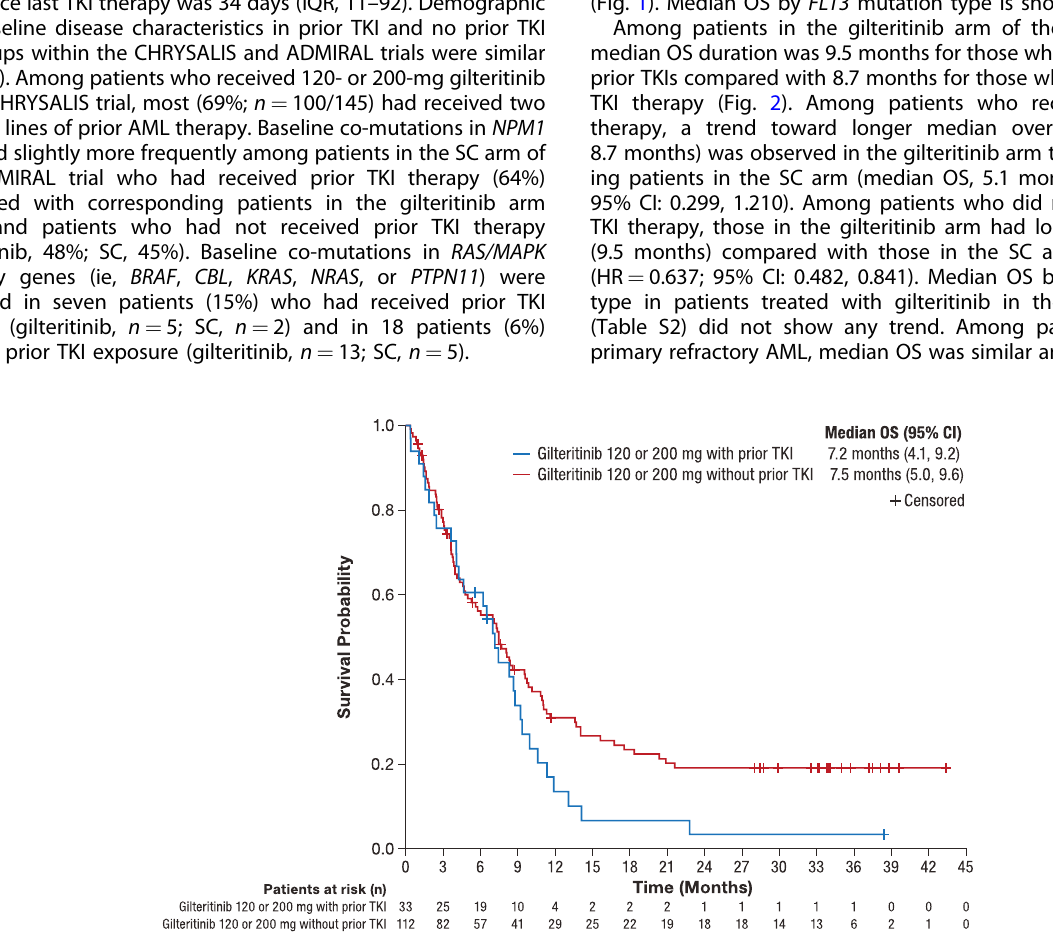
Fig. 1 Overall survival by prior TKI status: CHRYSALIS trial. CI con fi dence interval, OS overall survival, R/R relapsed or refractory, TKI tyrosine kinase inhibitor.